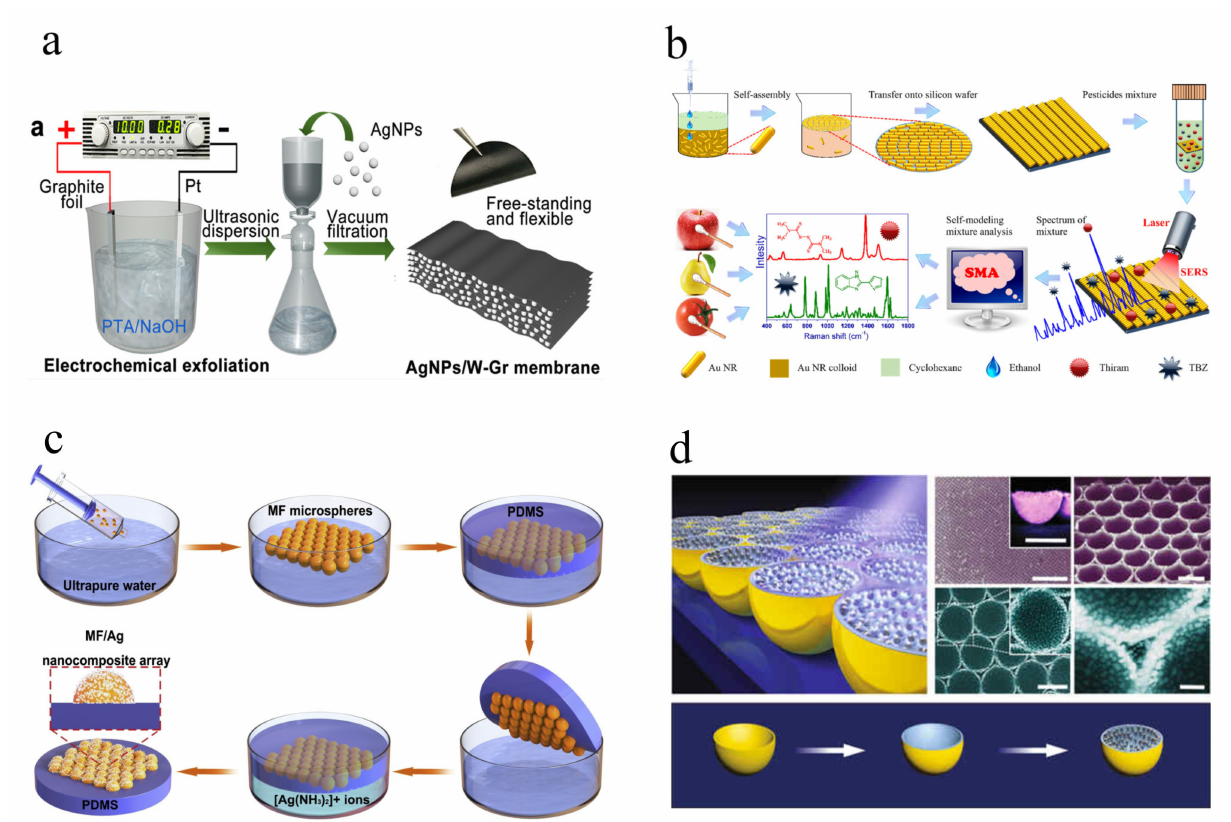
Figure 3. Schematic of the fabrication process of the AgNPs/W-Gr membrane ( a ). © 2022 Elsevier B.V. Adapted with permission from [24]. Schematic preparation of self-assembly gold nanorods (Au NRs) array and detection of pesticides on fruit surface ( b ). © 2022 Elsevier B.V. Adapted with permission from [87]. Schematic preparation diagram of hierarchical MF/Ag array substrate ( c ). © 2022 Elsevier B.V. Adapted with permission from [60]. Schematic illustration of preparation of NP-on-WS hierarchical substrate ( d ). © The Author(s) 2018. Adapted with permission from